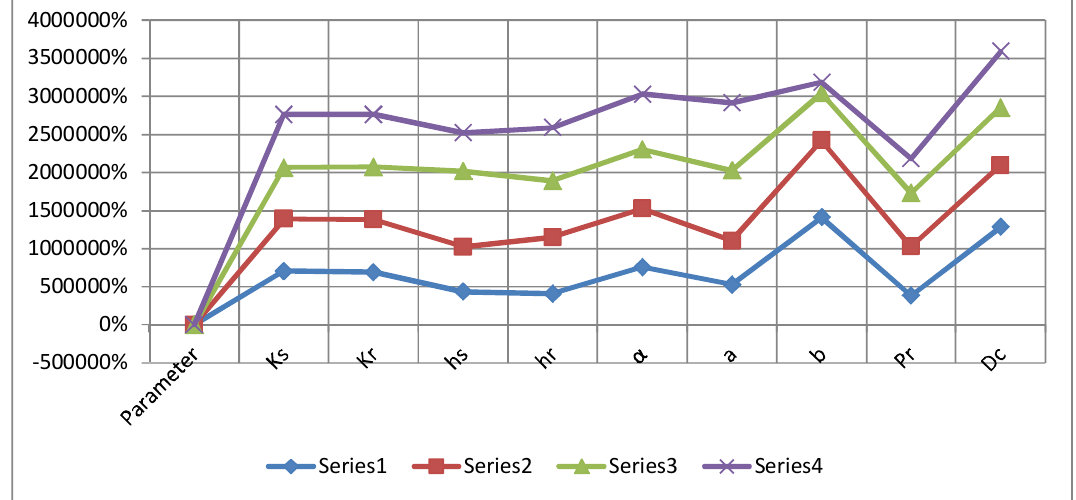
Fig. 5. Total cost per unit time sensitivity analysis